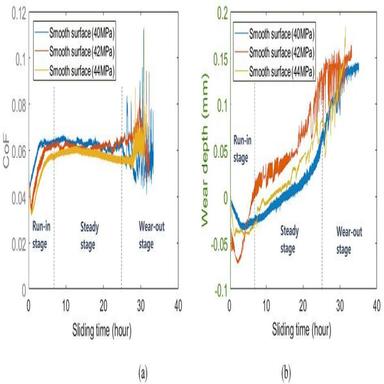
Comparison of (a) coefficient of friction (CoF) and (b) wear progression of the PTFE composite sliding against smooth (i.e. non-textured) steel surfaces in different nominal contact pressures.